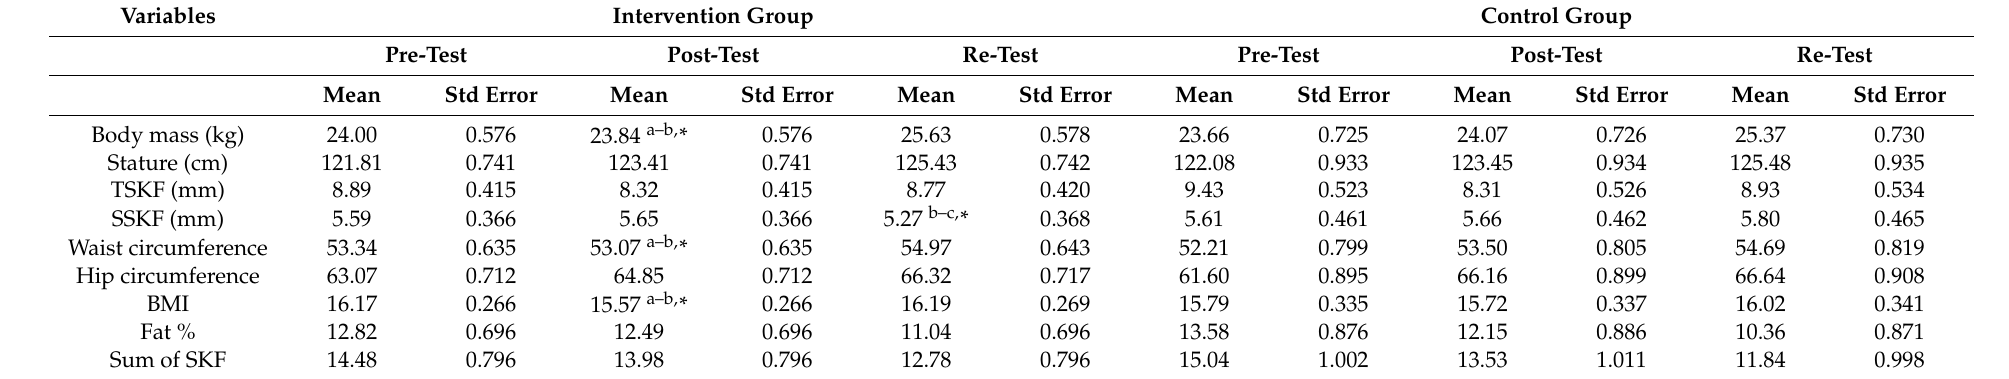
Table 1. Anthropometric characteristics and body composition of the participants (study sample) according to group and